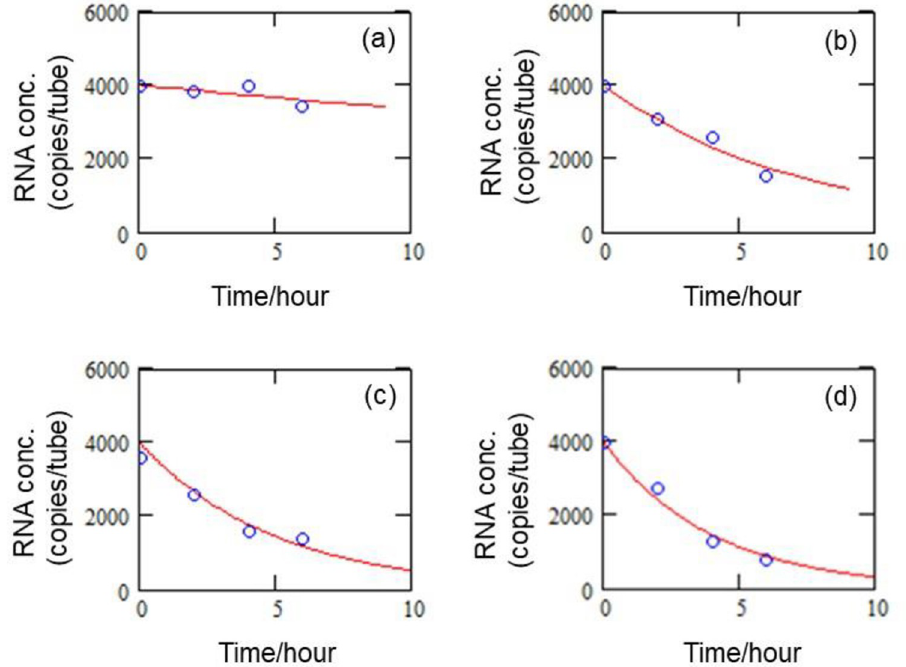
Fig 3. Time-dependent degradation of RNA at (a) 4˚C (b) 25˚C, (c) 37˚C, and (d) 45˚C.